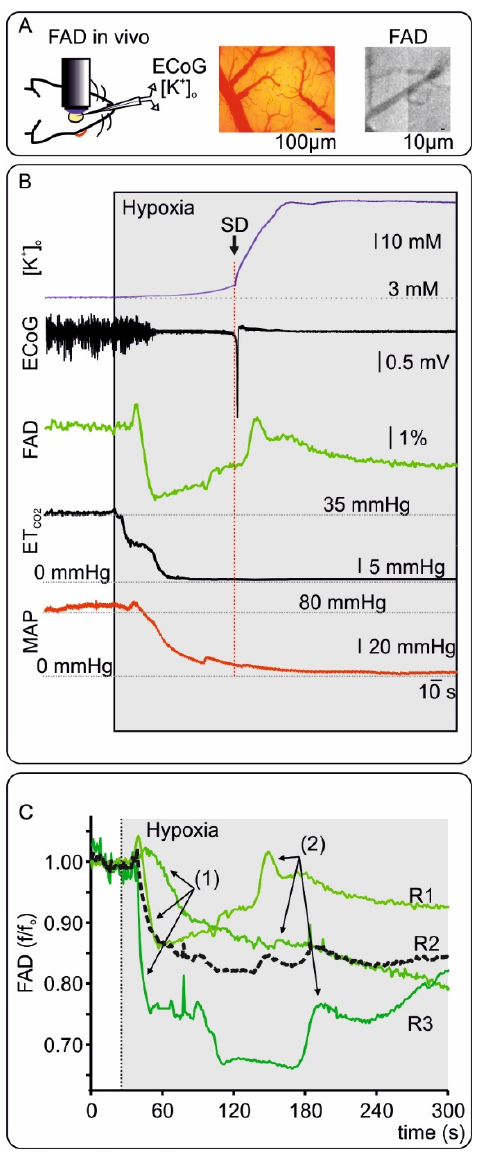
Figure 5 . Changes in Flavin adenine dinucleotide (FAD) fluorescence in vivo during hypoxia. ( A ) Left: Representation of in vivo FAD microscopy combined with alternate current (AC) electrocorticography (ECoG) and extracellular potassium ([K + ] o ) measurements. Middle: Picture of the cortex with pial vessels. Right: CCD picture (460nm LED illumination and FAD filter) showing the cortical surface emitting fluorescence and dark pial vessels. ( B ) Exemplary experiment concerning in vivo changes in FAD during terminal hypoxia and related signals. A few seconds after beginning ventilation with 0% oxygen, [K + ] o (blue, trace on top) gradually increased and cortical activity ceased (=non-spreading depression of activity, AC-ECoG trace). FAD-signal displayed a short oxidative peak followed by a marked reductive course. End tidal CO 2 (ET CO2 ) and mean arterial pressure (MAP) decreased indicating circulatory arrest. After about 110 s of hypoxia and significantly after the circulatory arrest (defined as a fall of ET CO2 to zero and a MAP below 30 mmHg), terminal SD then occurred characterized by the sharp and large rise in [K + ] o and parallel abrupt large negative shift of the direct current (DC)-ECoG. The terminal SD led to a last oxidative FAD-Peak. ( C ) FAD traces from three in vivo FAD measurements (R1-3) during hypoxia. Black dotted line represents the average curve of all traces. As shown previously, acute hypoxia is related to FAD reductive shift (1) and an oxidative peak when terminal SD occurs (2). The exemplary recording in B correspond to R1 in C. For details concerning the individual recordings, see supplementary Figure 2.